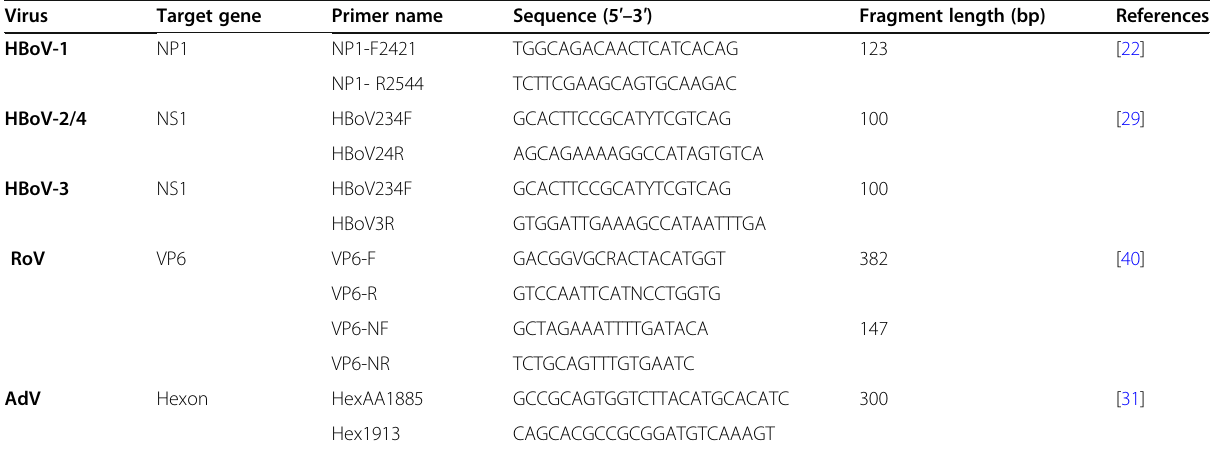
Table 1 Primer sequences of HBoVs, AdV, and RoV Virus Target